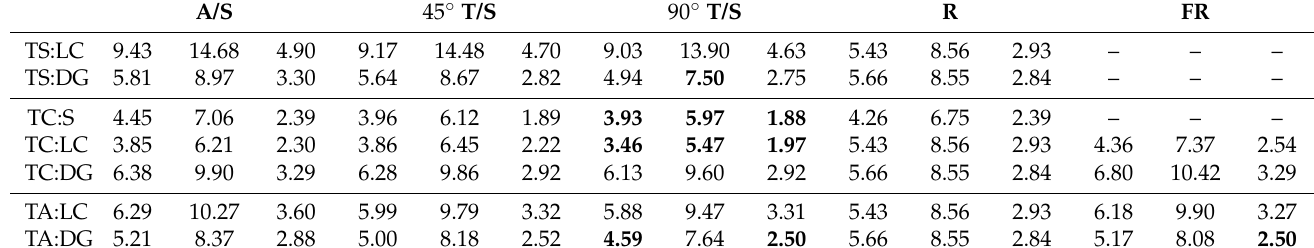
Table 3. Reconstruction errors ( RMSE wp , Hauss, avHauss ) using the map-less path reconstruction algorithms described in Section 4.4.2. Units of meters. For each community of walkers (S, LC, DG), the smallest error values for each metric are shown in boldface.